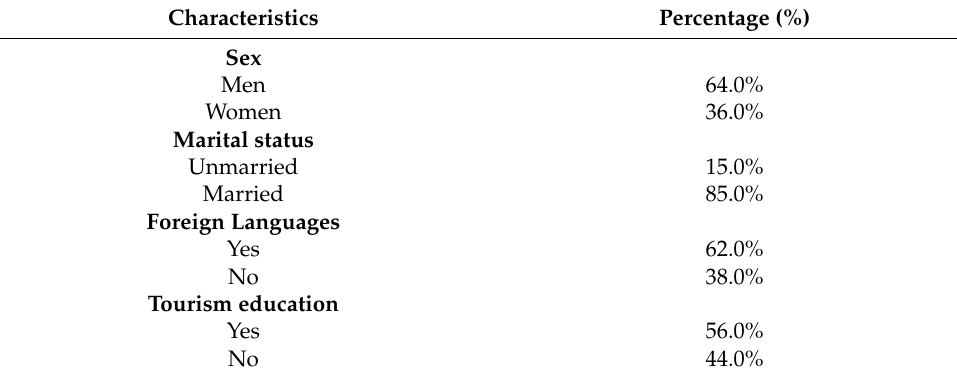
Table 3. Characteristics of